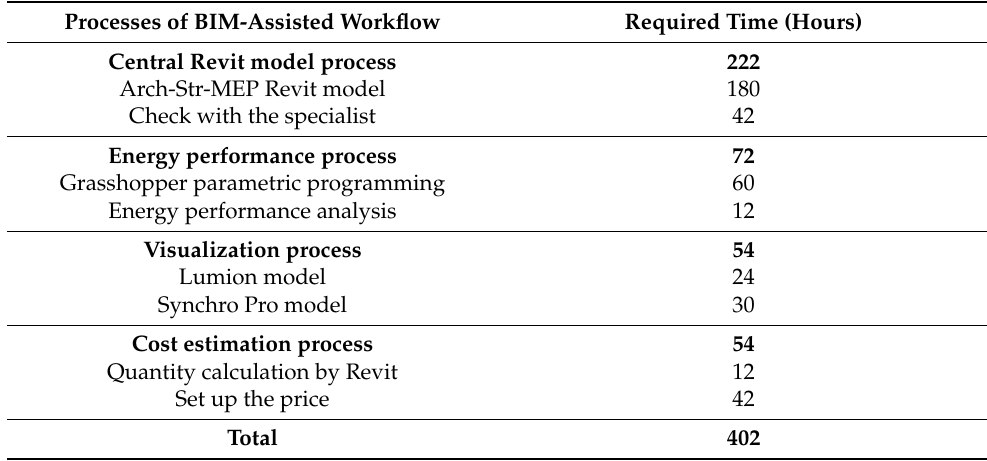
Table 3. Duration results of BIM-assisted workflow.